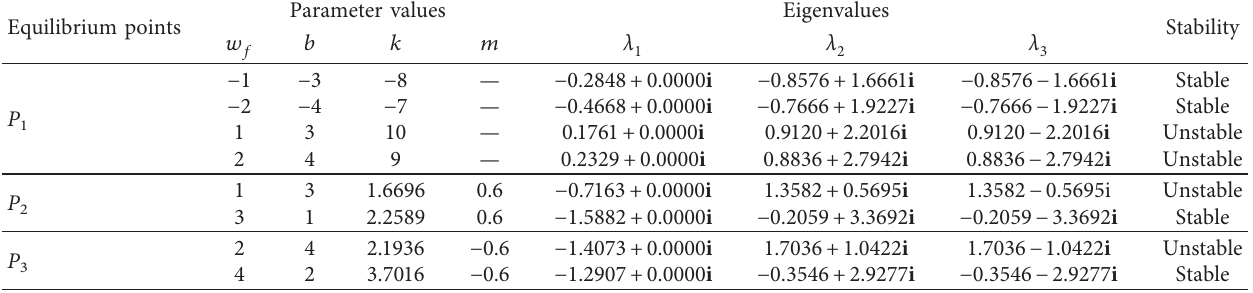
,P , and P obtained from equations (7) and (8) for different values of w f , b,k, and m . 1 2 3 Parameter values Eigenvalues